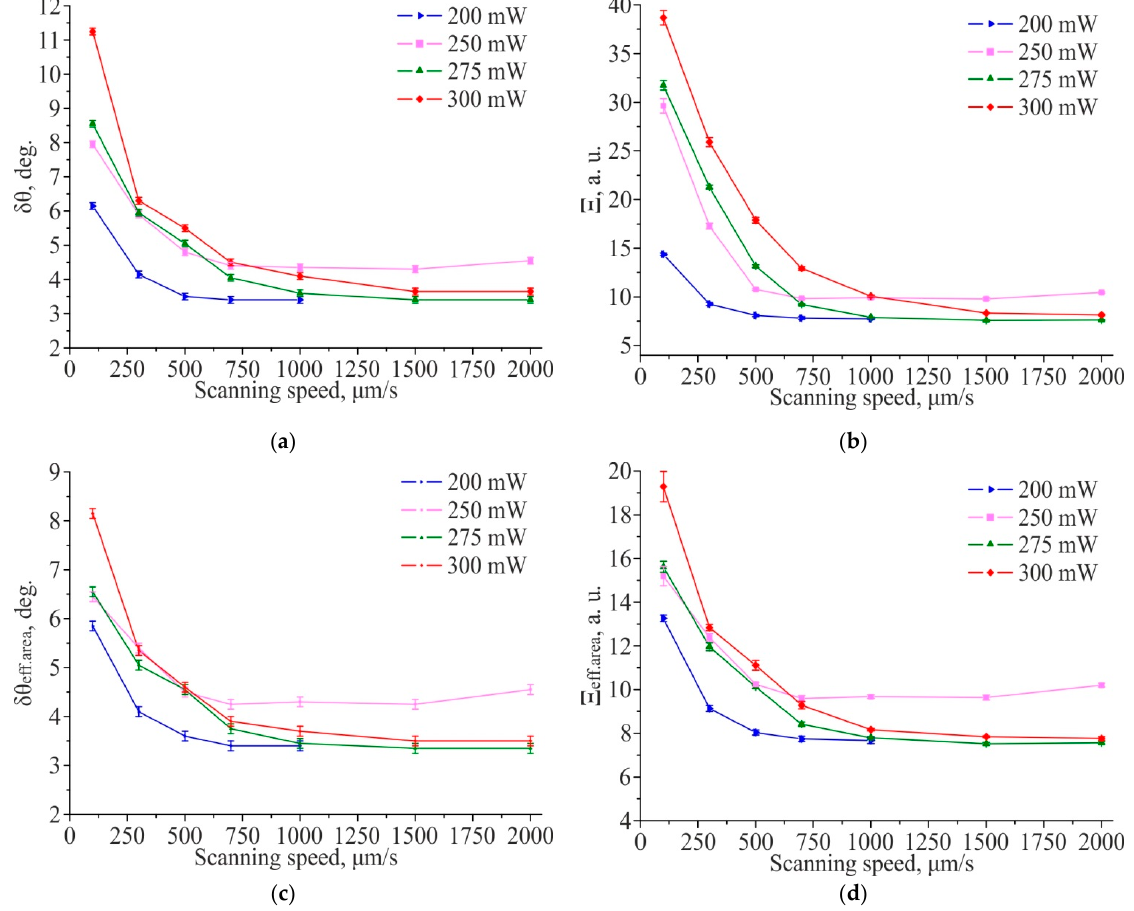
Figure 9. Dependences of the structures’ straightness δθ ( a ) and the structures’ parallelism Ξ parameters ( b ) for TLIPSS formed on a hafnium film in a low vacuum at different scanning speeds and laser powers, corresponding values for δθ eff.area ( c ) and Ξ eff.area ( d ).